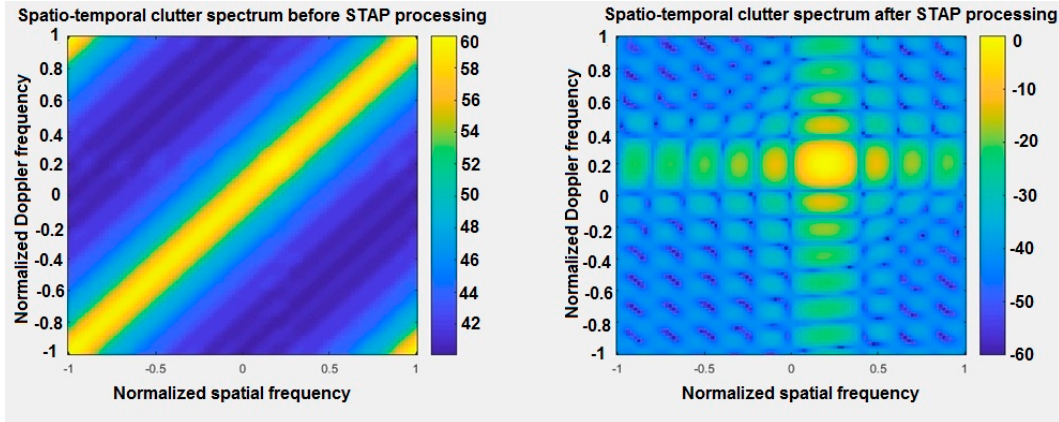
Figure 2. Space-time spectrum of clutter before and after STAP processing—2D charts.